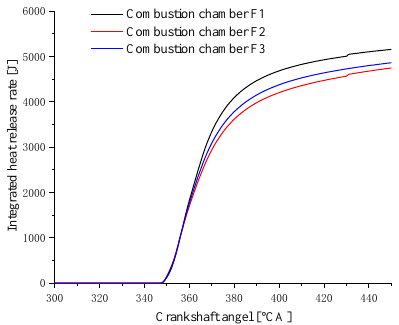
Figure 18. Comparison of integrated heat release rate curves of three combustion chamber schemes matched with the 160° spray angle injector.